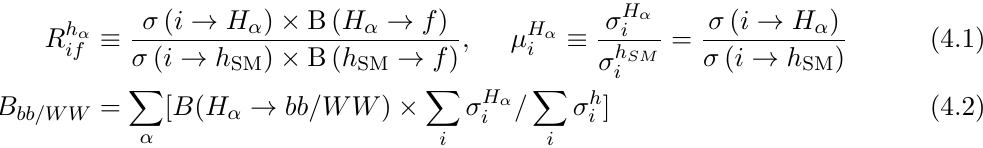
is smaller or larger, the surviving samples reappear because N much small. This corresponds to the green samples in the left-bottom corner on the right plot in figure 7. The right plot supports our conclusion that the samples satisfying DM direct detection limits must have a smaller higgsino